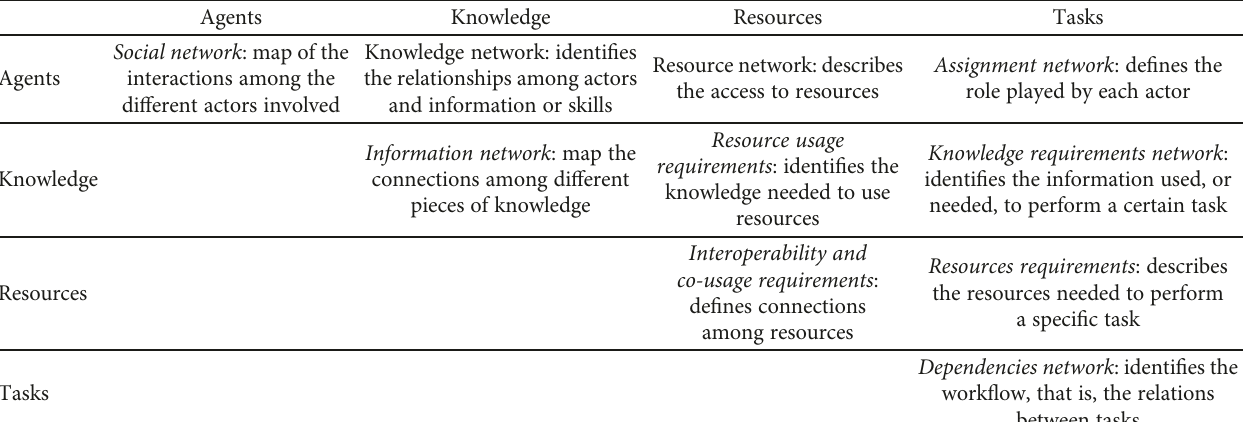
Table 3: Metamatrix framework showing the connections among the key entities of social network (adapted from [54]).